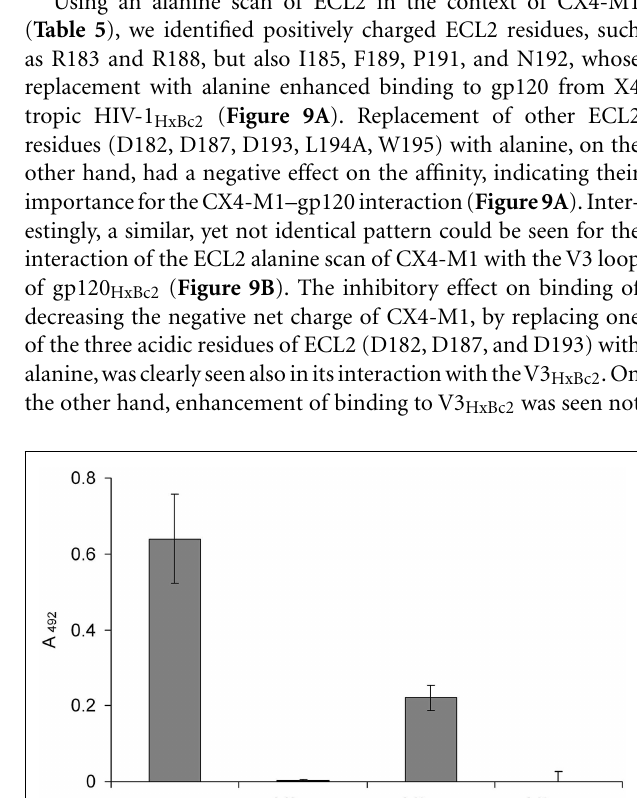
FIGURE 8 | Effect of alanine substitutions inV3 HxBc2 on binding to the CXCR4 mimetic peptide CX4-M1 . See Section “Materials and Methods” (direct ELISA) for experimental detail. Relative absorbances ( A r ) were